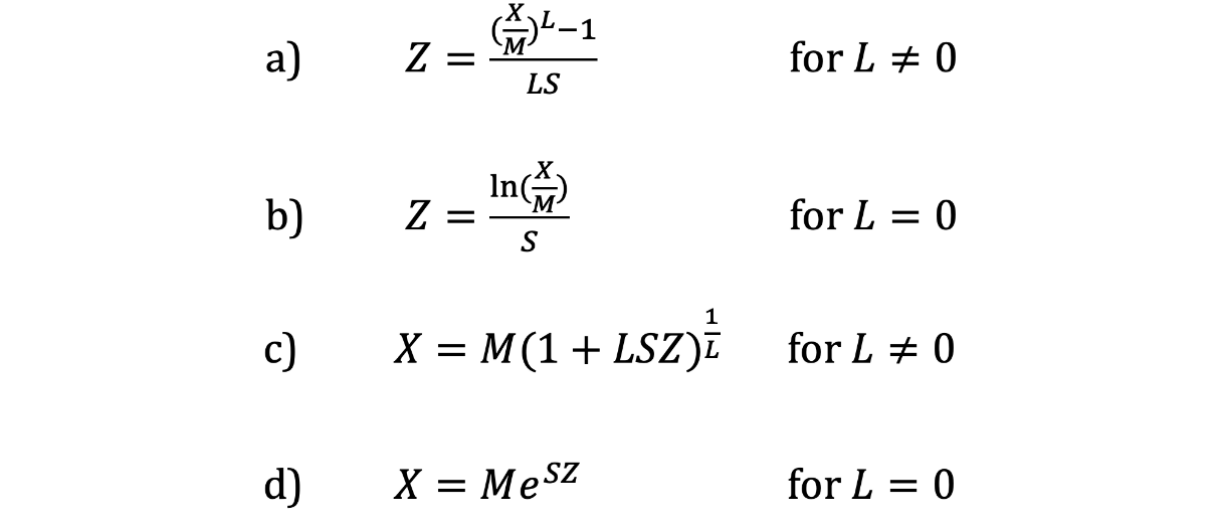
Figure 1. Equations for LMS-based growth metric calculations for Z score (a and b) and for an anthropometric measurement X (c and